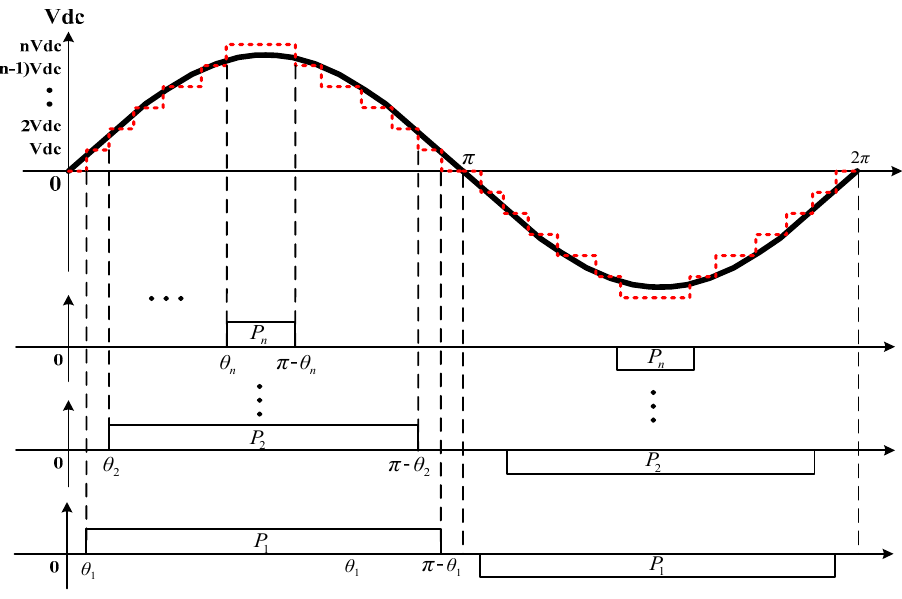
Figure 12. Waveforms and switching method of n-level cascade inverter.